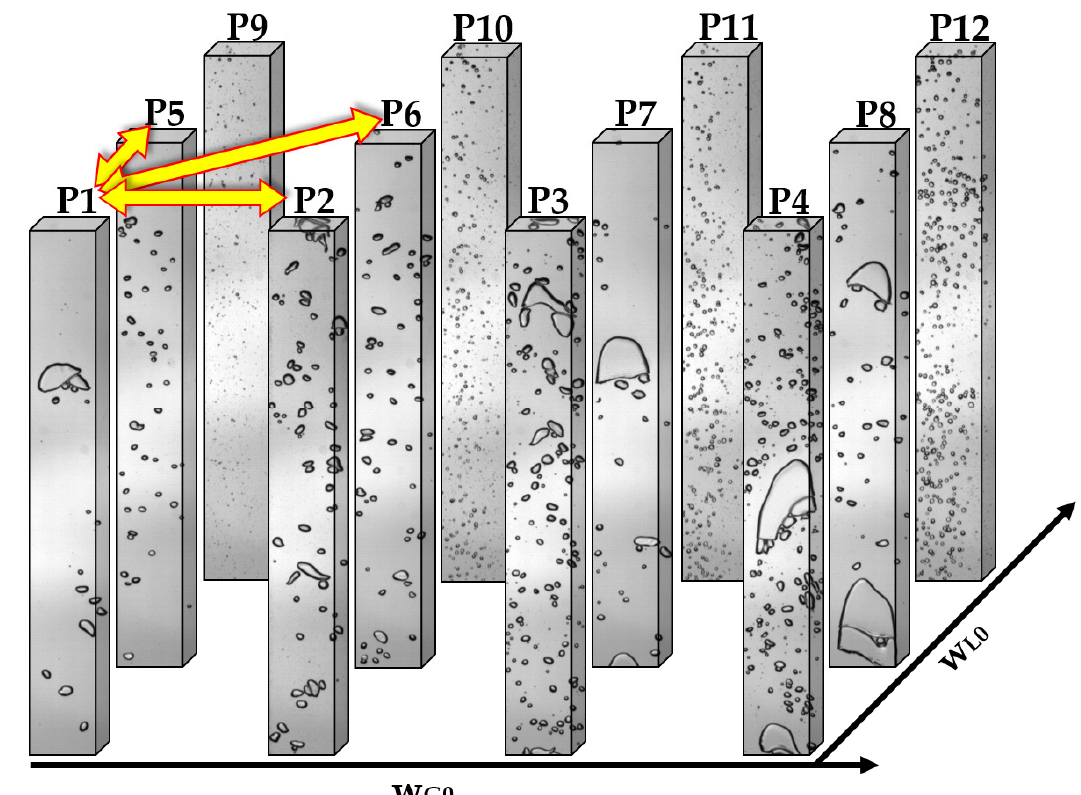
Figure 8. An ordered matrix of recorded images of two-phase flow patterns; the increment in gas phase velocity w G0 is left to right, and the increment in liquid phase velocity w L0 is from front to back.